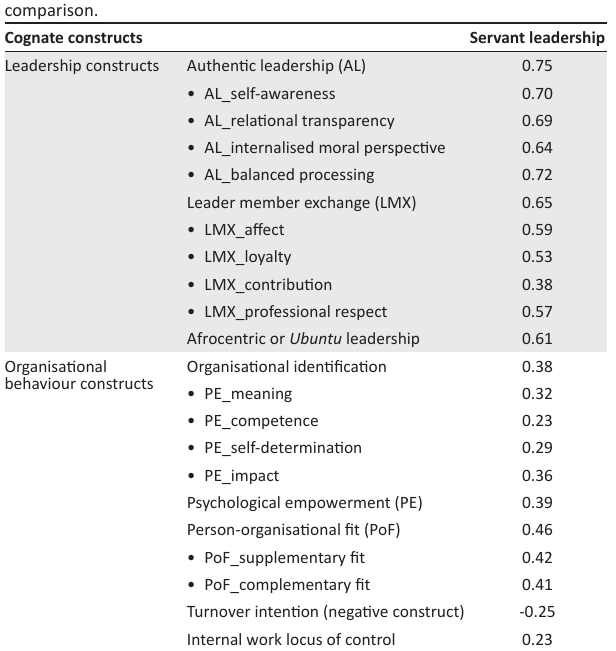
TABLE 7: Convergent validity of servant leadership (as measured by the seven- item servant leadership questionnaire) through heterotrait-monomethod comparison.